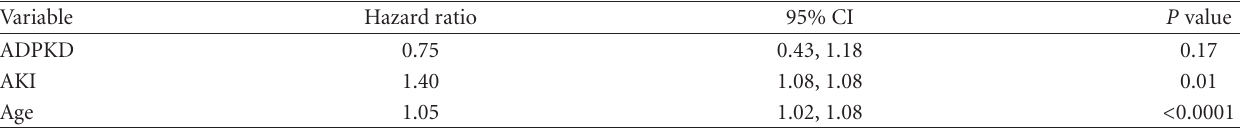
Table 5: Cox proportional hazards model showing the e ff ect of age, AKI, and ADPKD on